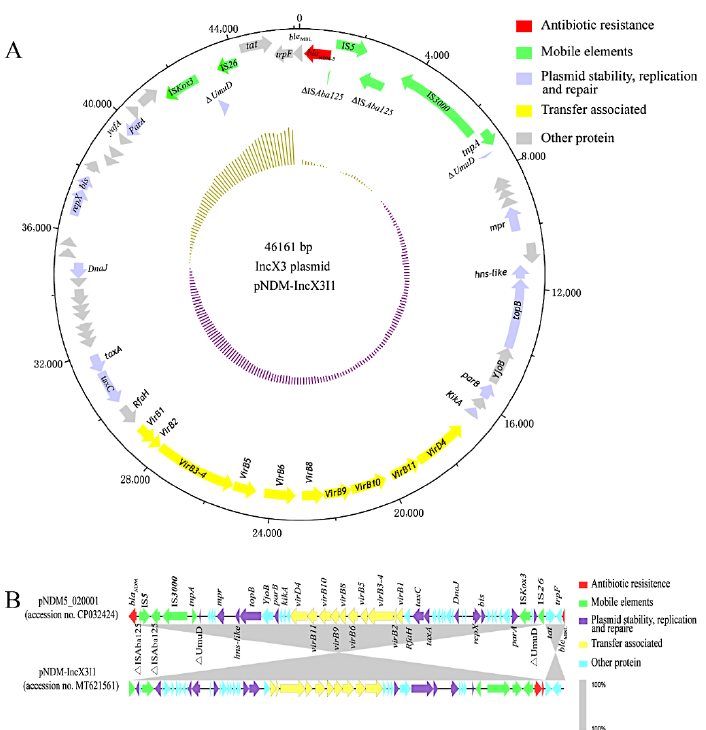
Figure 4. Schematic map of the IncX3 plasmid and genetic environment of bla NDM genes. Regions of ≥ 99.0% nucleotide sequence identity were shaded in gray. ( A ) Genetic environment of pNDM- IncX3I1. ( B ) Comparative genomics of pSDCRK-IncFNDM5 and pNDM5_020001.